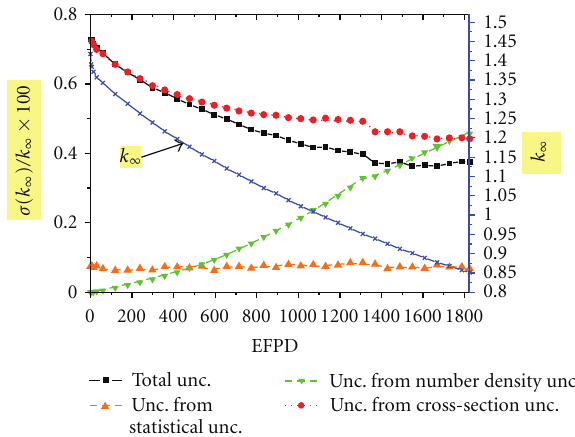
Figure 2: k inf and σ [ k inf ] versus pin burnup with ENDF/B-VII.1 covariance data.